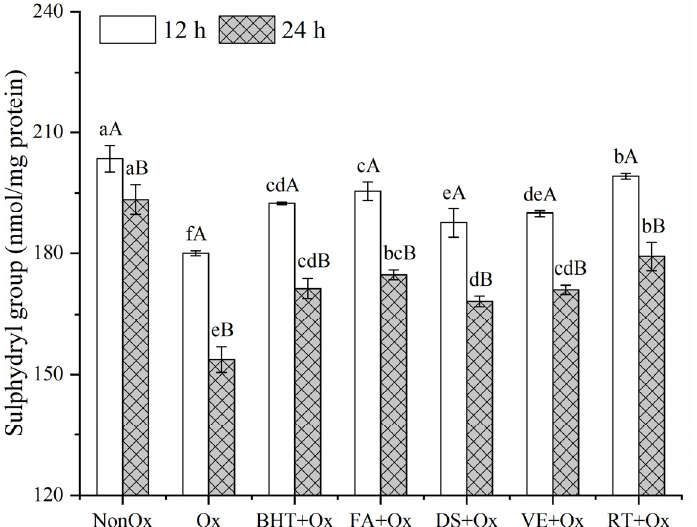
Figure 3. Protein sulfhydryl group of MPs in minced yak meat supplemented with different antioxidants. Note: NonOx—non-oxidized; Ox—oxidized without antioxidant; BHT + Ox, FA + Ox, DS + Ox, VE + Ox, and RT + Ox—oxidized in the presence of BHT, ferulic acid, diallyl sulfide, α -tocopherol, and rutin, respectively. a–d Means with different lowercase letters are significantly different among antioxidant treatments for the same oxidation time ( p < 0.05); A–B Means with different uppercase letters are significantly different between 12 and 24 h for the same antioxidant treatment ( p < 0.05).